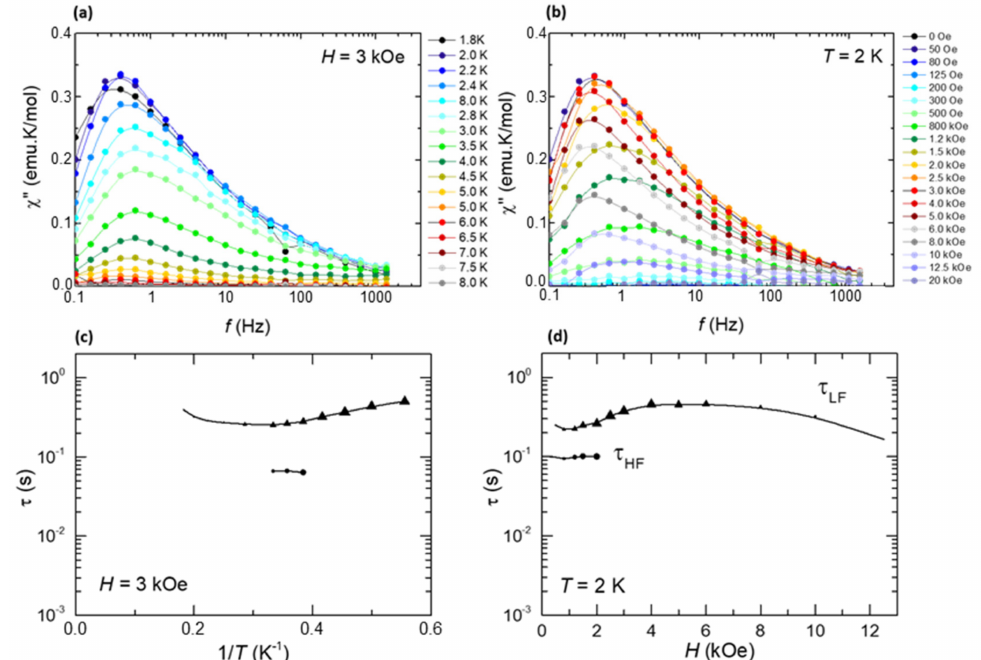
Figure 9. Top: out-of-phase component of the ac susceptibility as a function of the frequency, ( a ) at constant field H = 3 kOe and different temperatures, ( b ) at constant temperature T = 2 K and different applied fields for a powdered sample of ( 1 ). Bottom: magnetic relaxation time, ( c ) as a function of the inverse of the temperature, τ (1/ T ), at H = 3 kOe, and ( d ) as a function of the applied magnetic field, τ ( H ), at T = 2